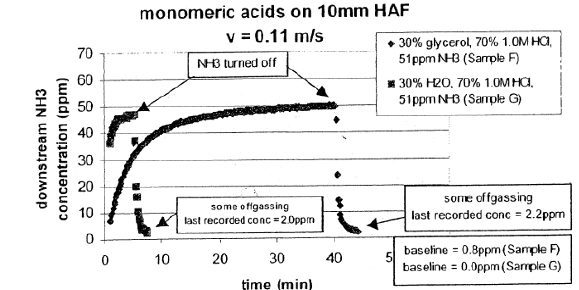
Figure 9. Ammonia trapping efficiency of acid-treated HAF.